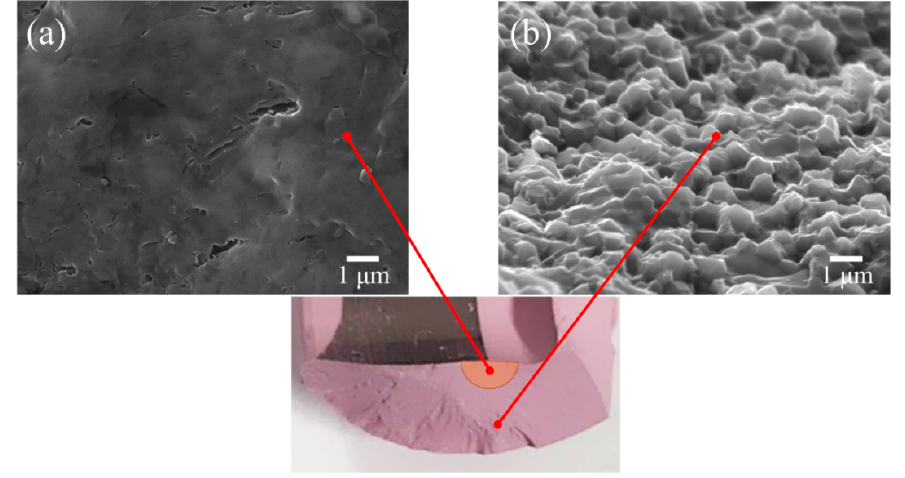
Figure 5. Scanning Electron Microscope images of two areas of the main fracture surface: ( a ) mirror-like and ( b ) intergranular.